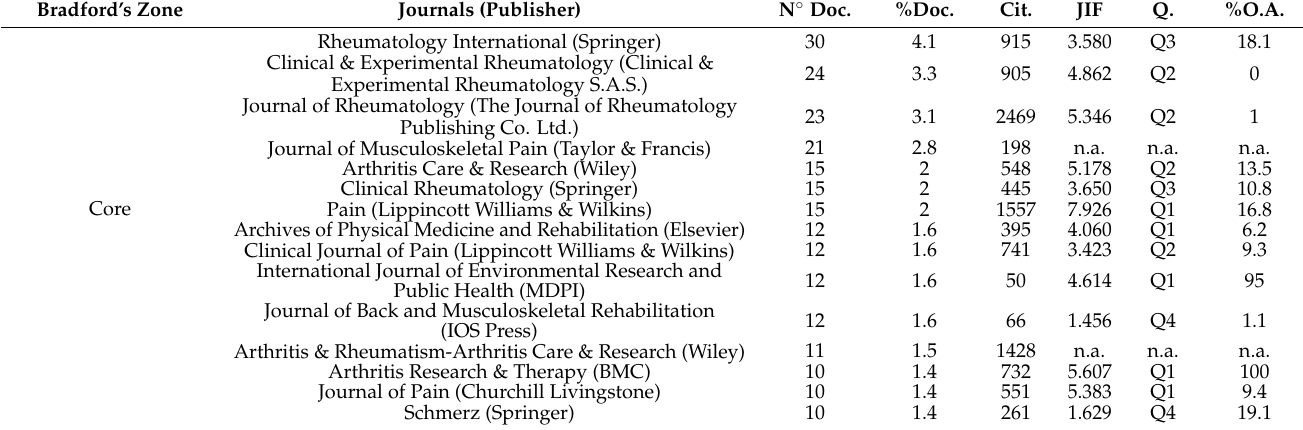
Table 1. Bradford’s Core journals according to the number of